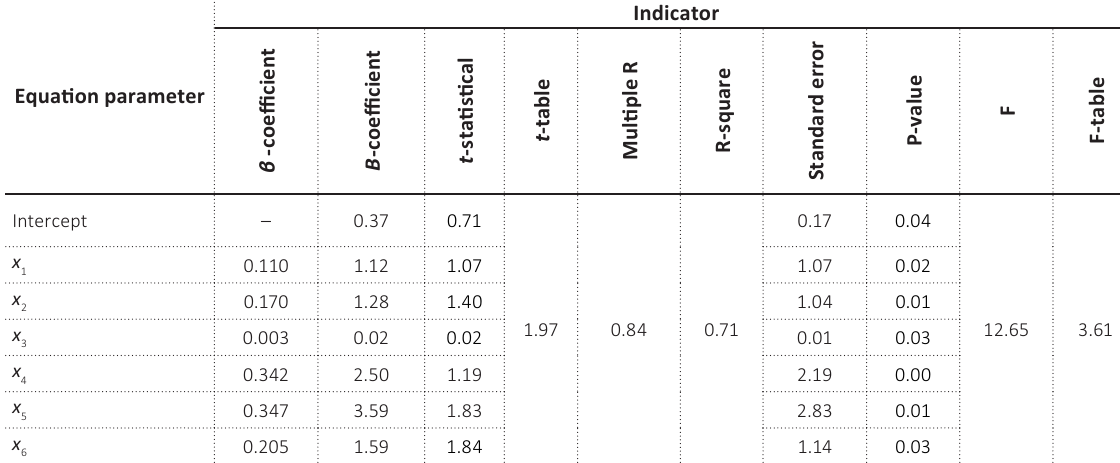
Table 1. Parameters of the regression model for calculating the indicator of insurance companies’ competitiveness on the travel services market